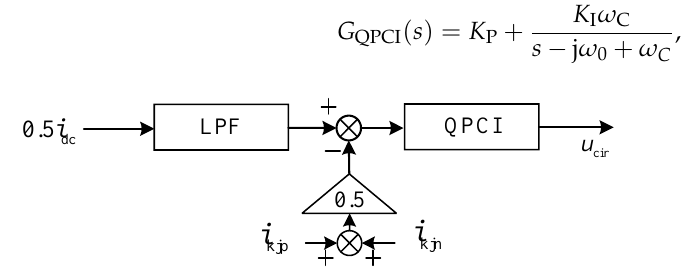
Figure 6. The control structure of circulating current suppressing.